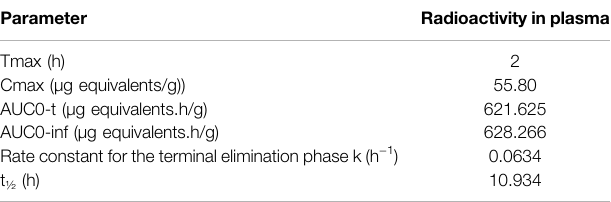
TABLE 3 | Routes and rates of excretion following a single oral administration of [ 14 C]DF2755AtofemaleSDratsatatargetdoseof20 mgfree-compound/kg. Sample (0 – 168